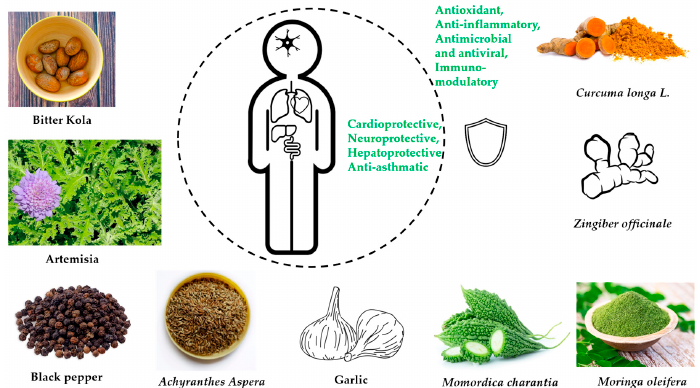
Figure 2. Graphical illustration of main health effects from traditional herbal remedies .